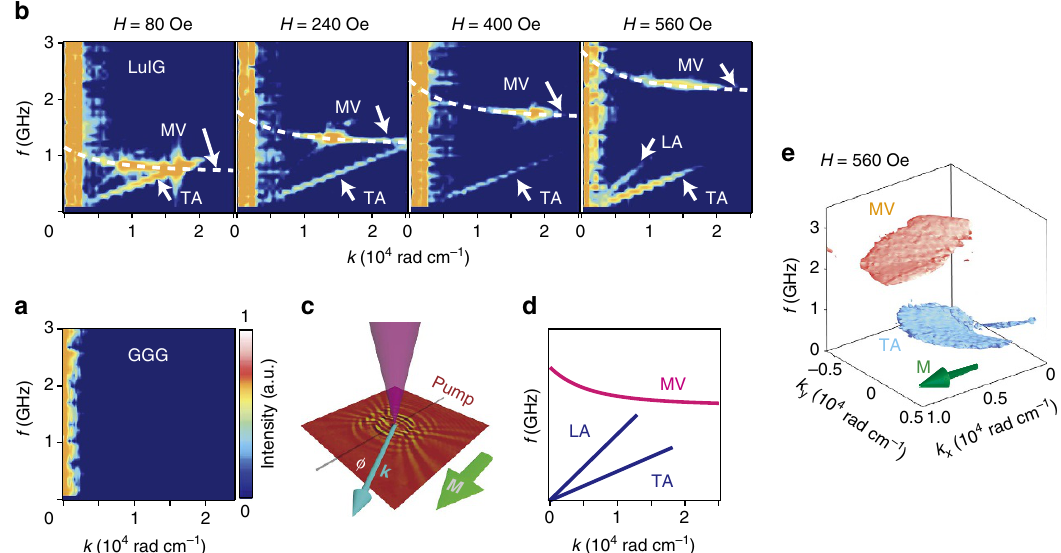
Figure 2 | SWaT spectra as a function of external magnetic fields. ( a ) A SWaT spectrum obtained for a paramagnetic GGG substrate without spontaneous magnetization. ( b ) SWaTspectra for the LuIG sample with wavenumber k parallel to the magnetization M , which was aligned along the [100] axis by an in-plane magnetic field H . We observe three different dispersion curves, which are schematically shown in ( d ). TA, LA and MV represent the transverse acoustic phonon, the longitudinal acoustic phonon and the magnetostatic volume mode branches, respectively. The white dashed curves are calculated by a magnetostatic spin wave theory 4 with the following parameters: saturation magnetization 4 p M s ¼ 780G, cubic anisotropy K c ¼ 2.3 (cid:3) 10 3 ergcm (cid:2) 3 and uniaxial magnetic anisotropy K u ¼ (cid:2) 1.2 (cid:3) 10 4 ergcm (cid:2) 3 . ( c ) A schematic of the experimental configuration. f is defined as the angle between k of spin waves and the orientation of M . ( d ) A schematic of the three branches observed in ( b ). ( e ) A three-dimensional contour plot (at the intensity of 0.7 in the scale shown in ( a ) of the SWaT intensity representing spin waves (red) and phonons (blue). The direction of M is indicated by the green